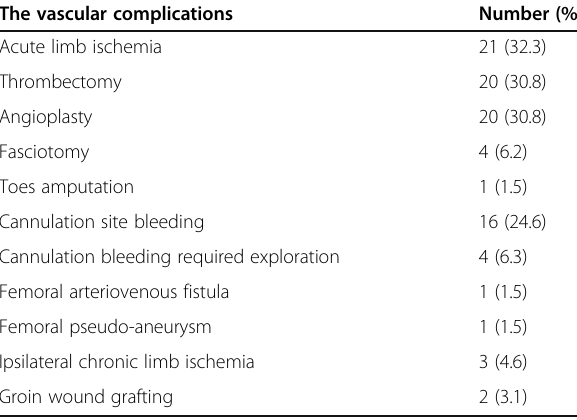
Table 2 The vascular complications of the studied